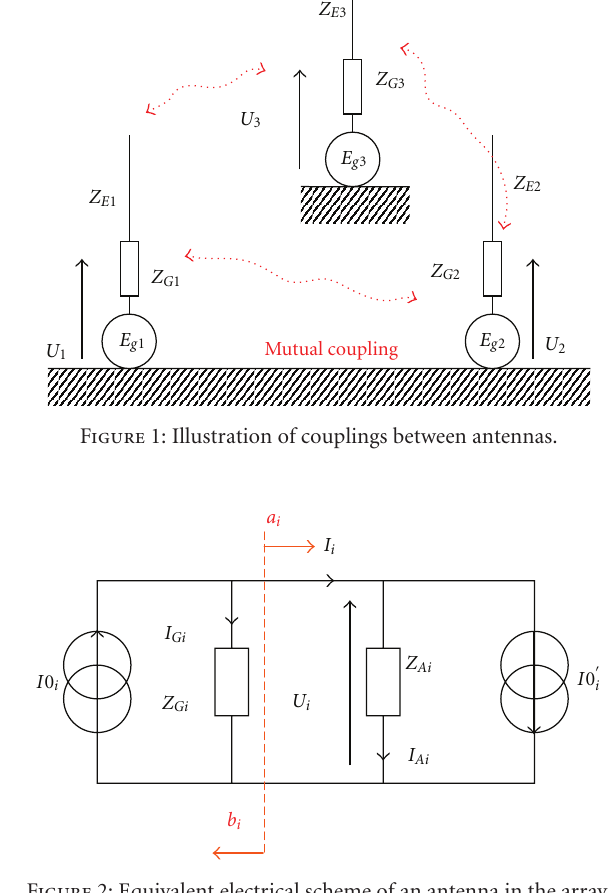
Figure 2: Equivalent electrical scheme of an antenna in the